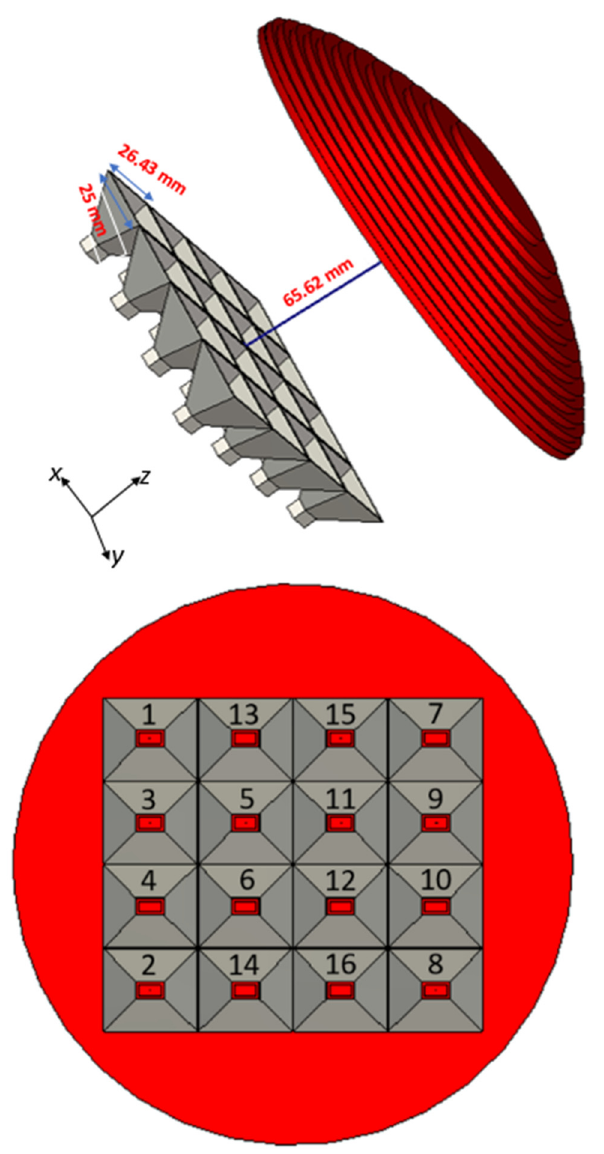
Figure 7. Sixteen switchable horn antennas with the designed reconfigurable dielectric lens. The diameter of the aperture area of the designed lens is a = 173 mm, the optimized focal point is f = 65.62 mm, and the number of slabs is thirteen slabs with a thickness t ∆ = 2.67 mm.